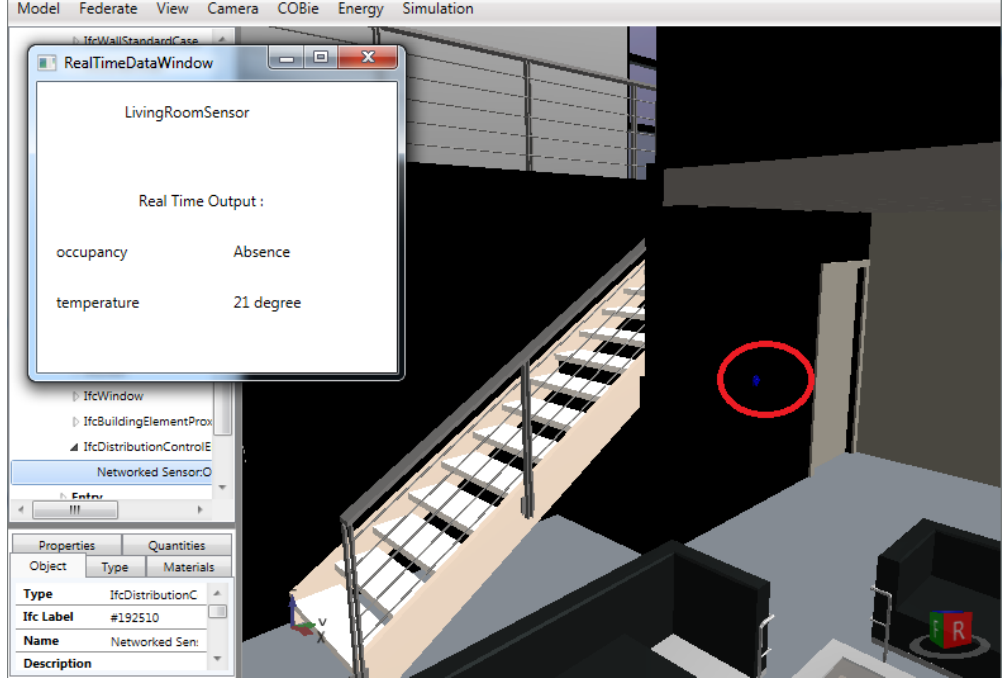
Figure 10. Real-time monitoring data display to the user.